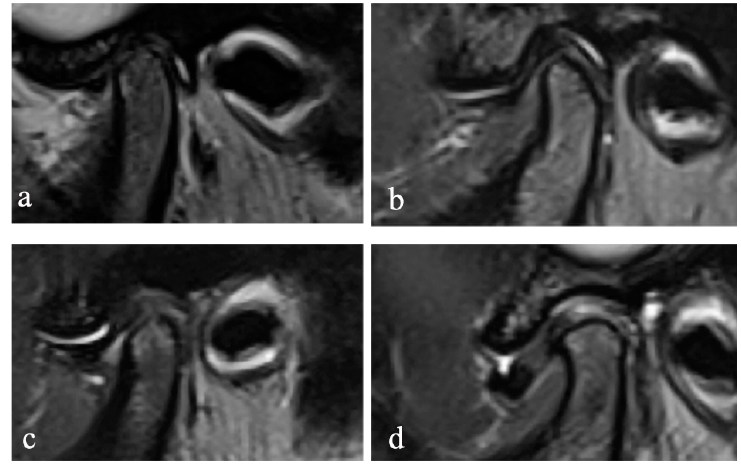
Figure 2. Joint effusion. Sagittal T2-weighted image MRI showing: ( a ) no fluid signal, ( b ) dots or lines of bright signal, ( c ) bands of bright signal, and ( d ) pooling of bright signal on the TMJ. The authors evaluated the condyle and the joint spaces on the CBCT images. The sagittal and coronal images were reconstructed by an axial view showing the maximum mediolateral dimension of the condyle. The slice thickness was 1 mm. On the reconstructed CBCT images, as described by Ahmad et al., the surface of each condyle was classified as normal, flattening, erosion, osteophyte, subcortical sclerosis, and subcortical cyst [20]. Each possible change could appear alone or in combination in at least two se-